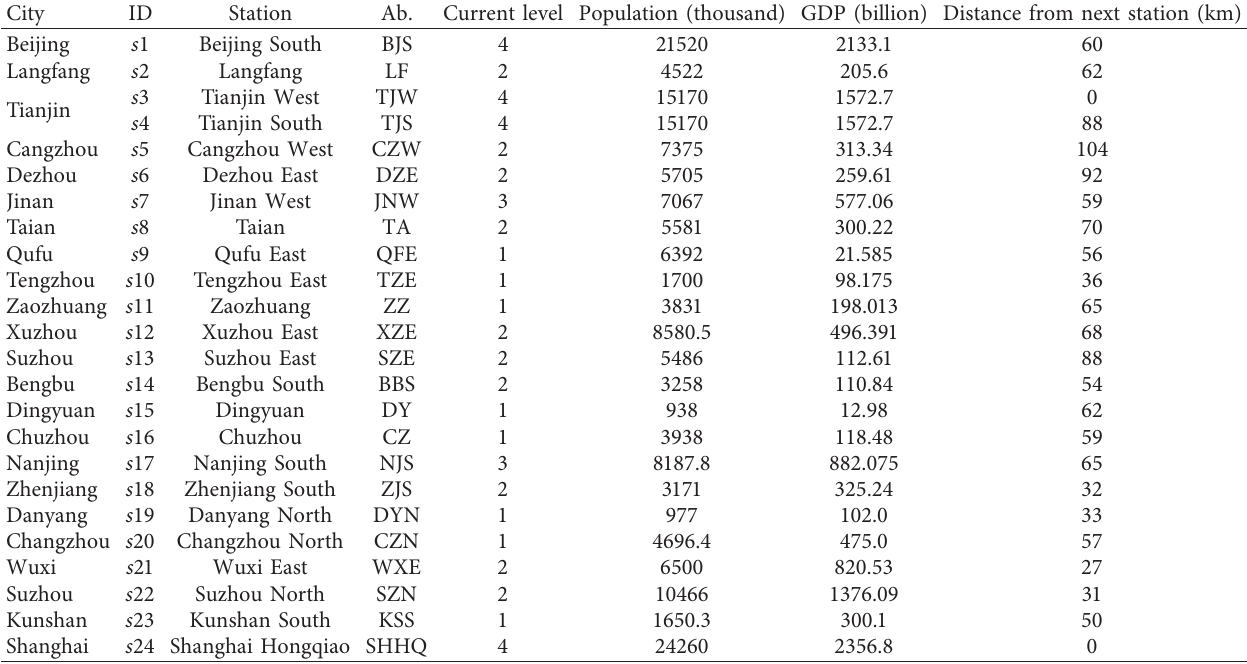
Table 2: Extracted features of service